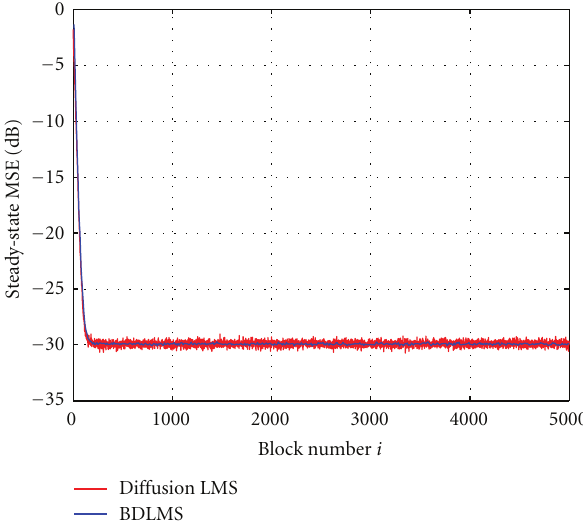
Figure 5: Global mean-square deviation (MSE) curve for di ff usion and block di ff usion